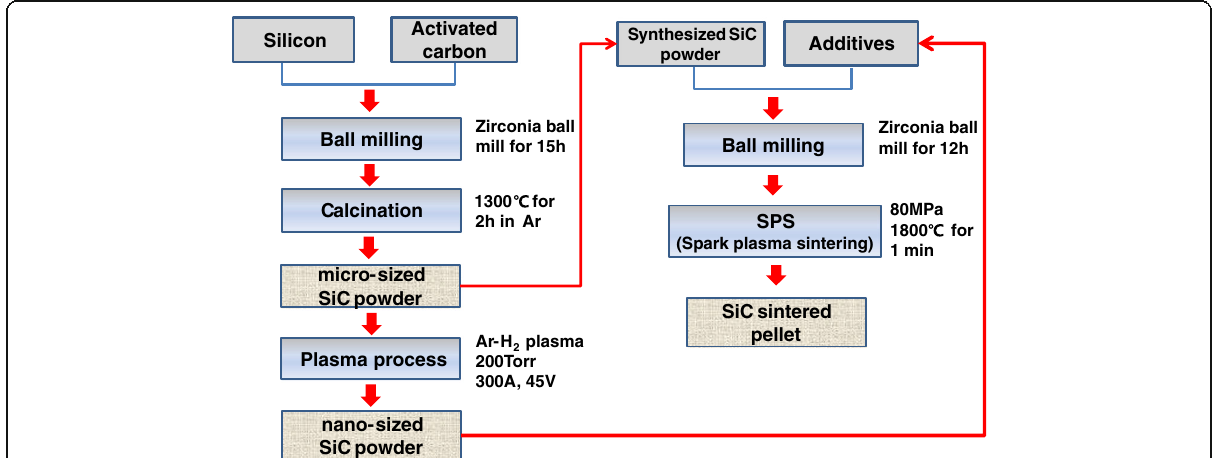
Fig. 1 Experimental procedure for preparing micron-sized SiC powder by calcination and nano-sized Si-SiC composite powder by plasma and for sintering SiC ceramics by